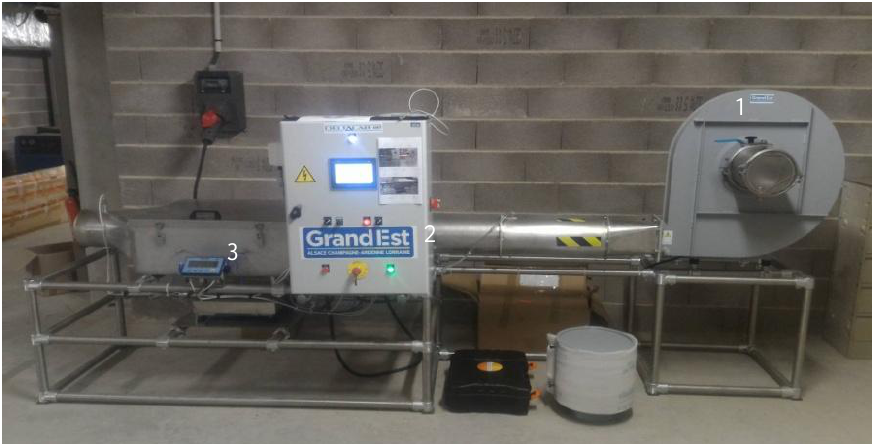
Figure 2. Experimental dryer .